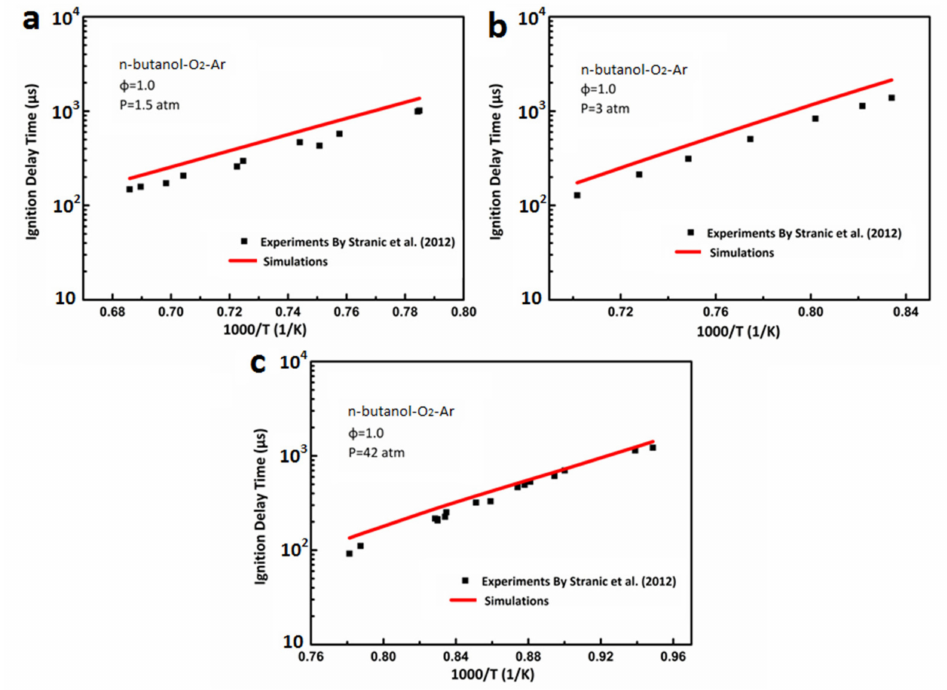
Figure 4. ( a ) Comparison of simulated and experimental ignition delay time of n-butanol at Φ = 1.0, 1.5 atm; ( b ) Comparison of simulated and experimental ignition delay time of n-butanol at Φ = 1.0, 3 atm; ( c ) Comparison of simulated and experimental ignition delay time of n-butanol at Φ = 1.0, 42